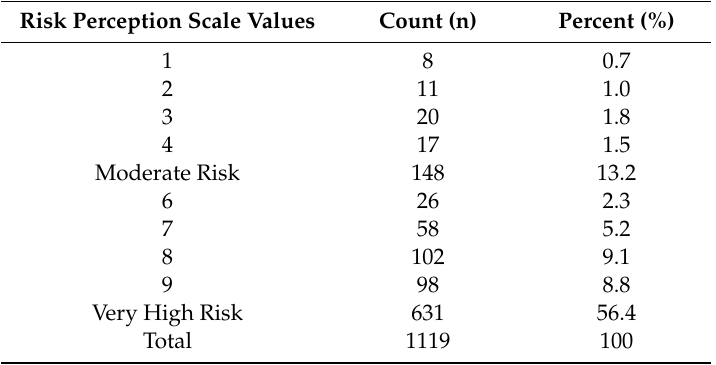
Figure 1. Percentage Distribution of Respondents by Overall Perceived Risk for working at height (WAH), manual handling of loads (MHL) and heavy workload or intense pressure to be more productive (HWP). Table 2. Number and Percentage Distribution of Respondents by Overall Perceived Risk.